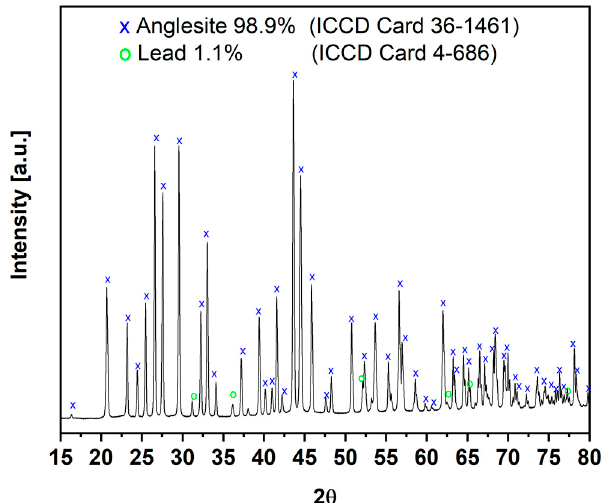
Figure 4. X-ray diffraction (XRD) pattern of Pb NW electrode after conditioning phase and at the end of the 100th discharge.